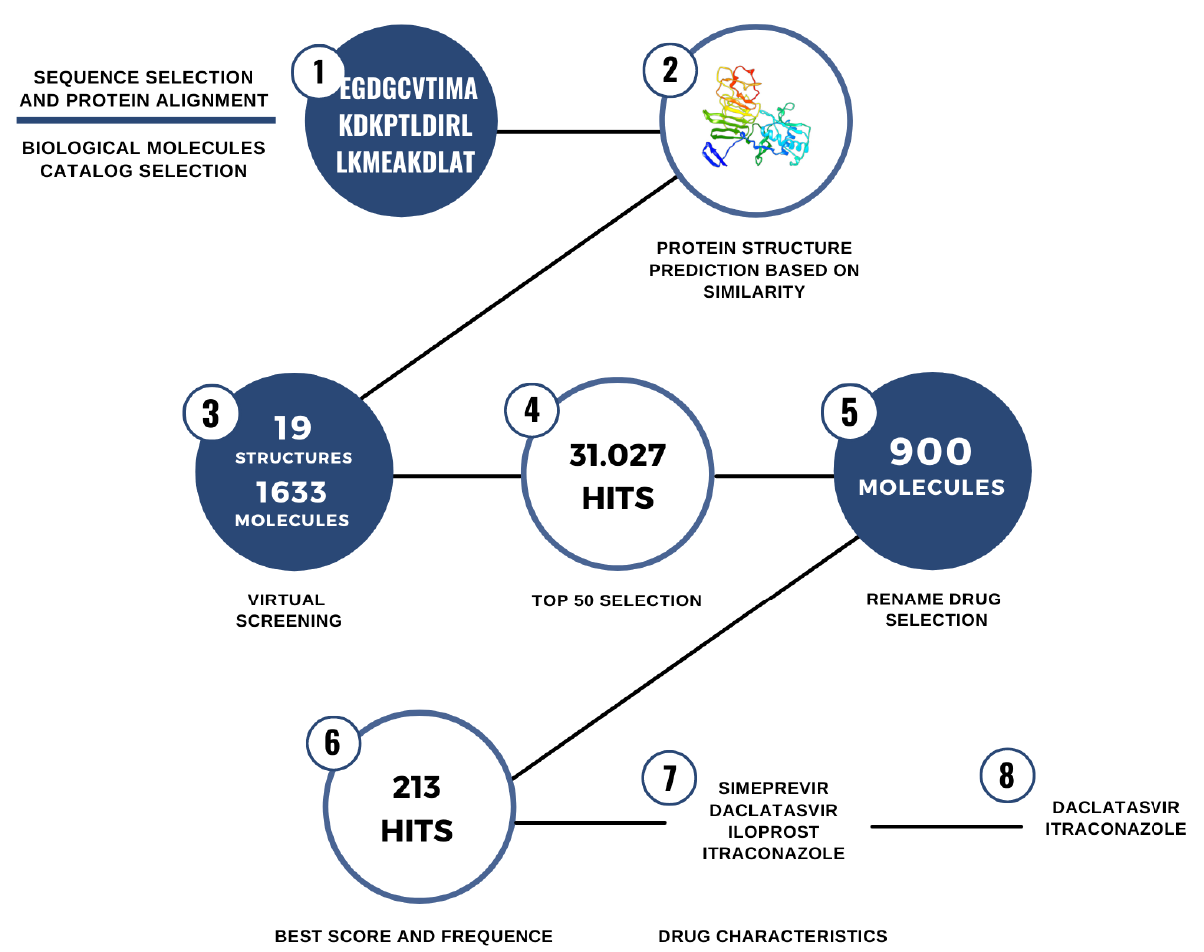
Figure 2. Steps for the identification of drug repurposing candidates for use against ROCV proteins .